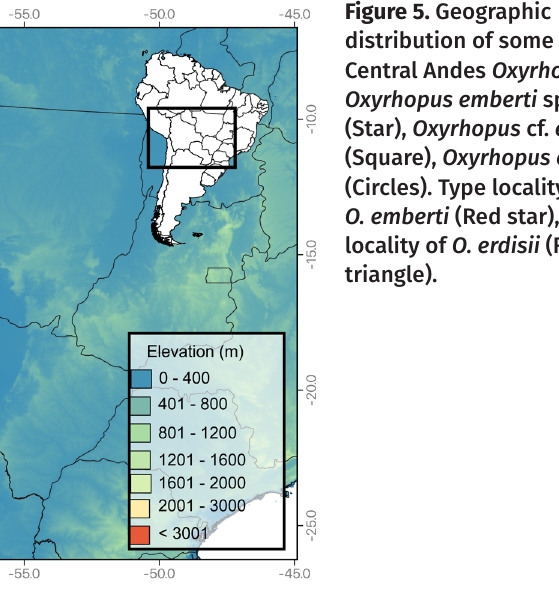
Figure 5. Geographic distribution of some Central Andes Oxyrhopus : Oxyrhopus emberti sp. n (Star), Oxyrhopus cf. erdisii (Square), Oxyrhopus erdisii (Circles). Type locality of O. emberti (Red star), type locality of O. erdisii (Red